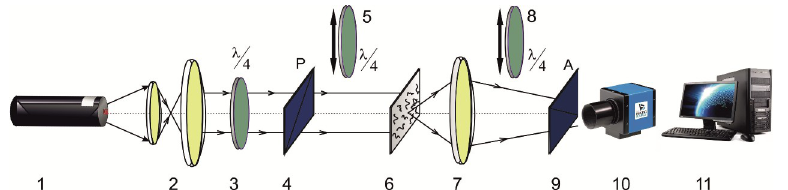
Fig 1. Schematic presentation of the Mueller-polarimeter experimental setup, including “blue” laser diode (1), collimator (2), stationary quarter-wave plate (3), mechanically movable quarter-wave plates (5) and (8), polarizer (4) and analyzer (9), object of investigation (6), infinity corrected strain-free objective with tube lens (7), CCD camera (10), personal computer